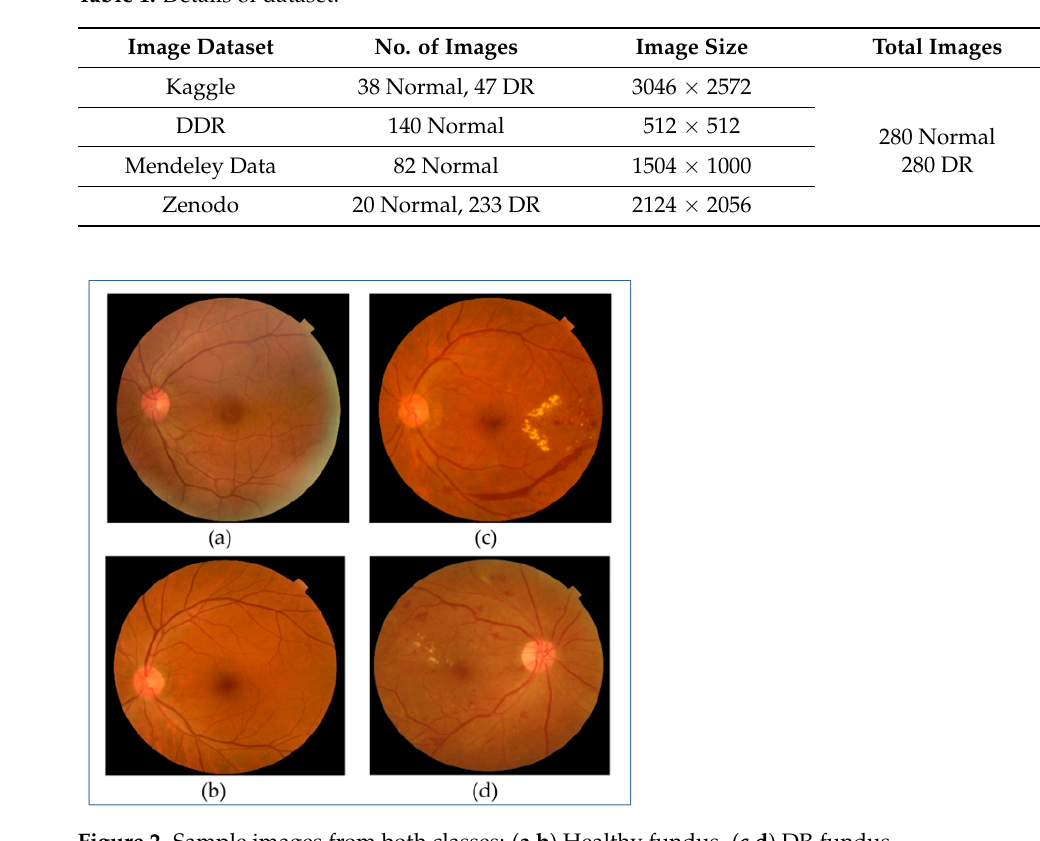
Figure 3. An overview of the proposed DR classifier. 2.2.1. Preprocessing and Segmentation This step is used to improve the overall quality of the fundus images in the datasets and to separate the different parts of the fundus, such as blood vessels, exudates, and microaneurysms (MAs). Figure 4 shows the step-by-step procedures for the pre-pro- cessing and segmentation. Figure 4. Overview of the proposed DR classifier.